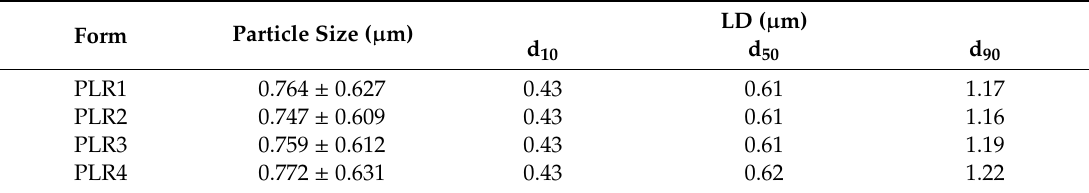
Table 2. Laser di ff ractometry (LD) diameters distribution of spray-dried lipid dispersions.